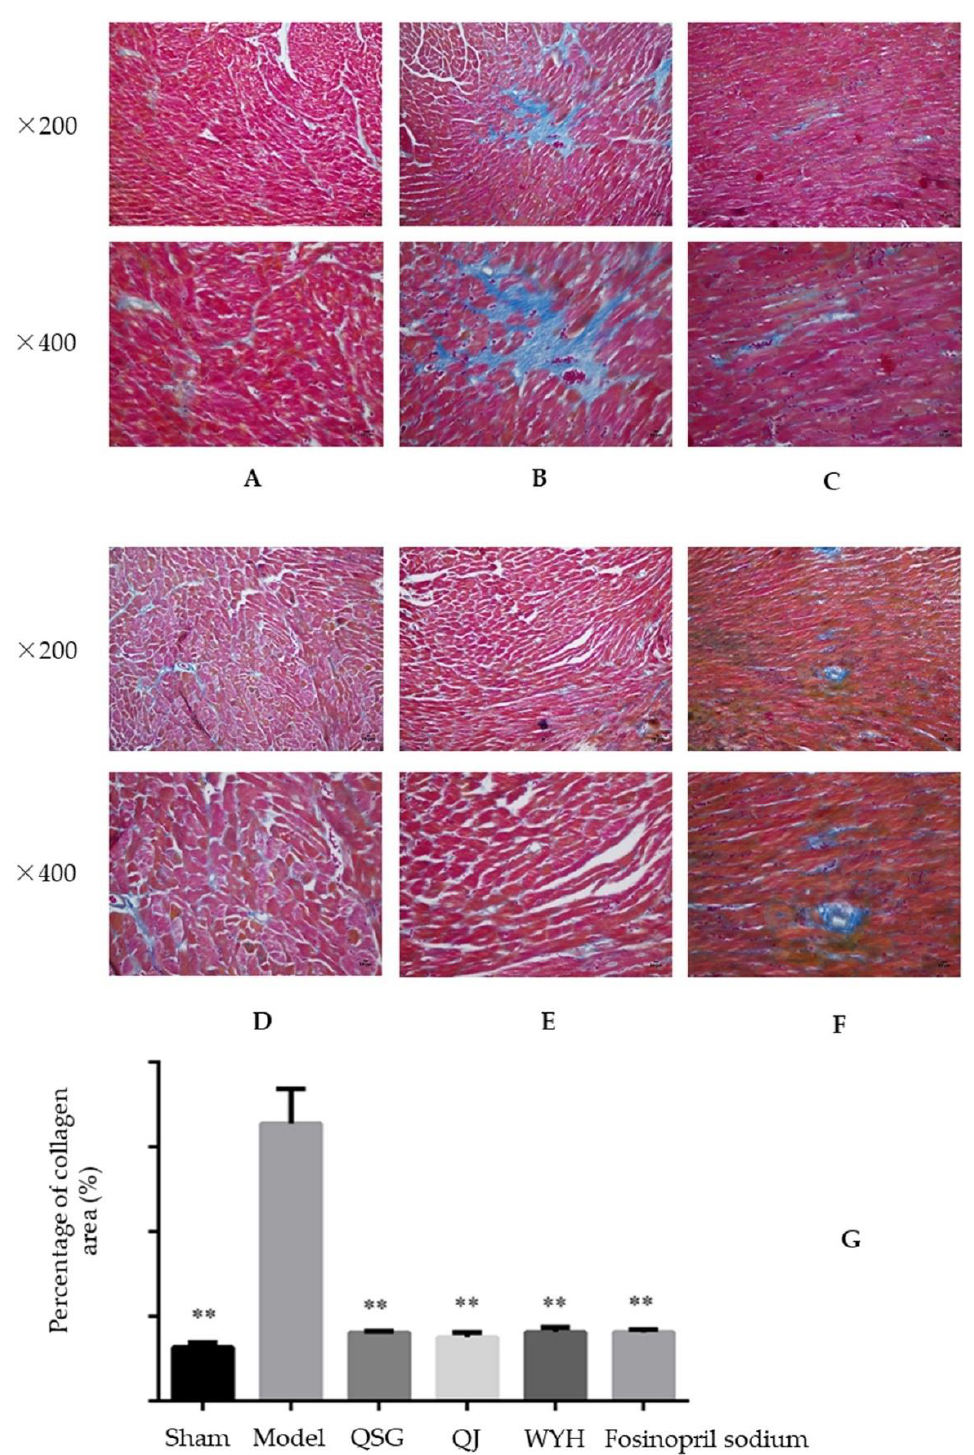
Figure 2. Mallory staining of the mouse heart from various treatment groups at the two indicated magnifications (×200 and ×400). ( A ) Sham group; ( B ) Model group; ( C ) QSG-treated group; ( D ) WYH-treated Group; ( E ) QJ-treated group; and ( F ) Fosinopril sodium-treated group. ( G ) the percentage of collagen in each of these groups. ** p < 0.01 relative to the model group. All data are presented as mean ± SE.